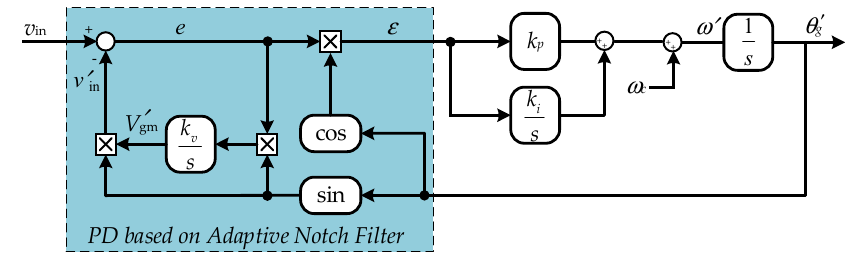
Figure 4. General structure of the Enhanced PLL (EPLL).